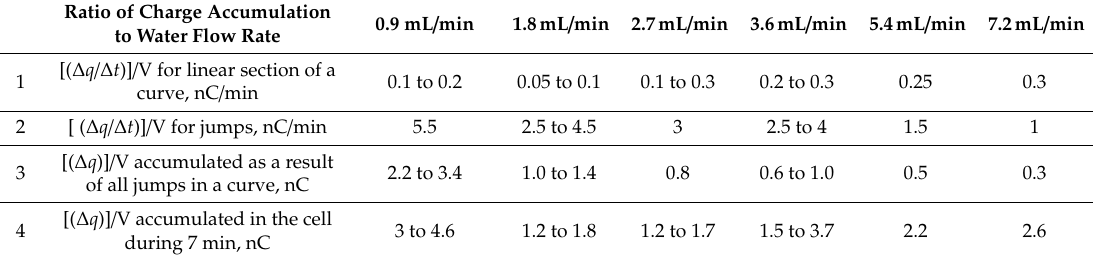
Table 2. Measurements of charge accumulated in the measuring cell, normalized per water flow rate ( V